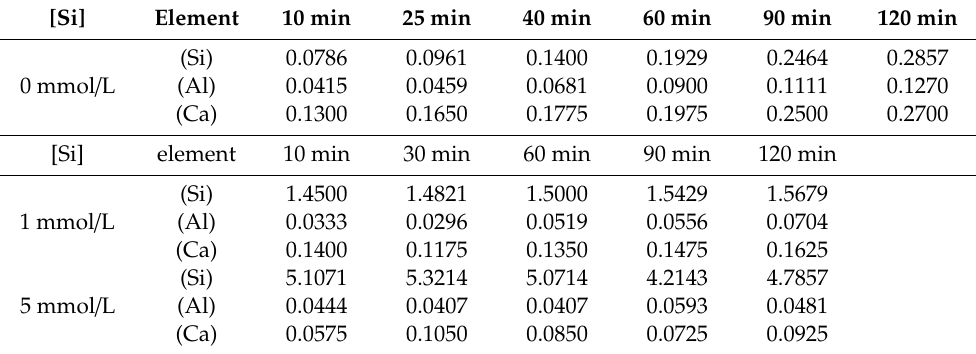
Table 4. Measured elemental concentrations of Si, Al and Ca (mmol / L).